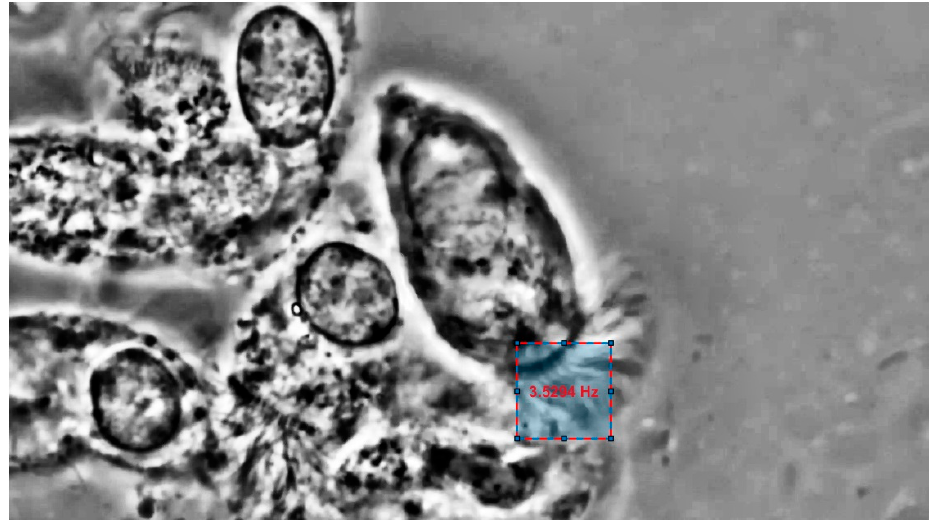
Figure 8. A graphical representation of the results obtained from cilia 4. This figure emphasizes the